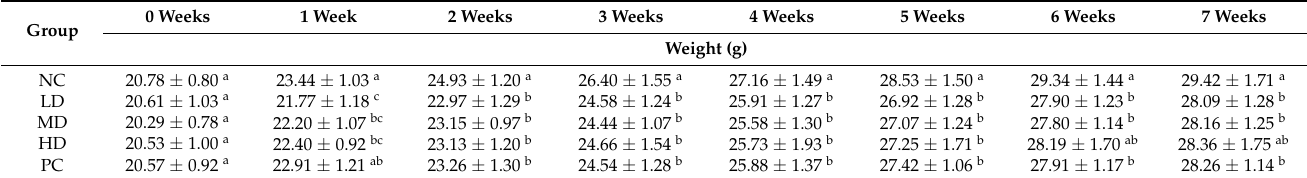
Figure 4. Results of elevated cross maze test. ( A ) Total exercise distance of mice from different groups. ( B ) Proportion of time in open area of mice from different groups. ( C – G ) Movement trajectories of mice from different groups. The open area is marked in green lines, the red lines represents the closed area, and the central area is marked in yellow lines. Different lowercase letters represent significant differences between groups ( p < 0.05). NC: normal control, LD: low dose, MD: middle dose, HD: high dose, PC: positive control. Table 2. Effect of Hairtail fish ( Trichiurus lepturus ) glycoprotein (HGP) on body weight of experimental